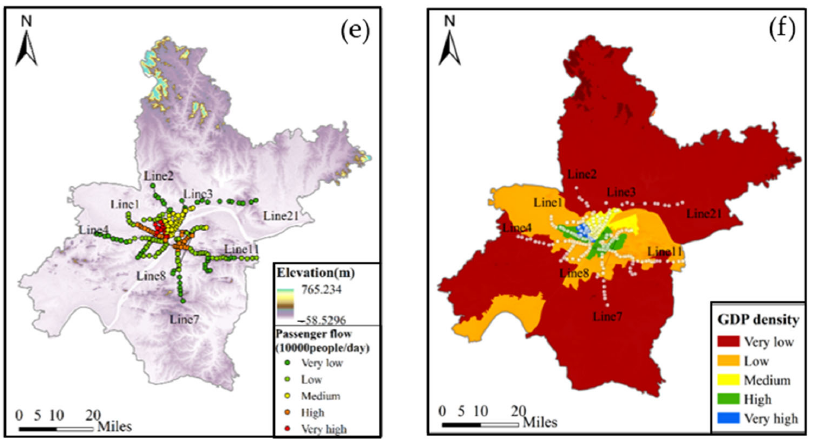
Figure 14. Node Characteristics. ( a ) Node degree. ( b ) Node strength. ( c ) Node betweenness. ( d )